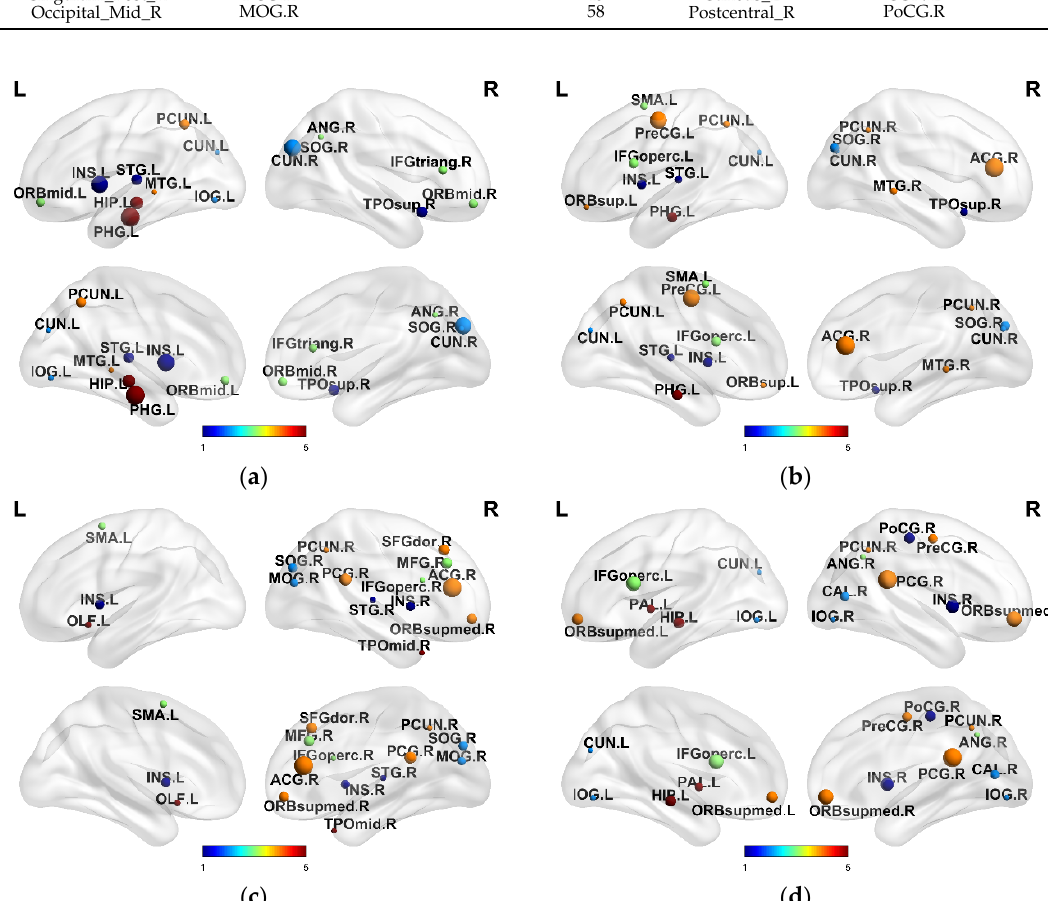
Figure 6. Visualization of discriminative brain regions. ( a ) NC vs. AD, ( b ) NC vs. LMCI, ( c ) NC vs. EMCI, ( d ) EMCI vs. LMCI.